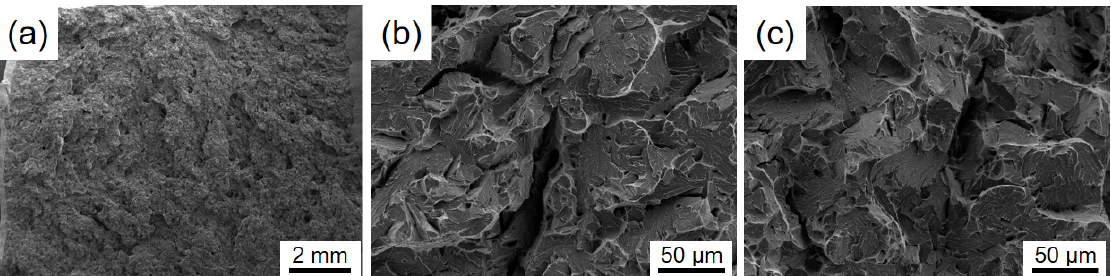
Figure 8. Morphology of fracture surface of Q1050 impact tested specimen. ( a ) overall macro-morphology of fracture surface, ( b ) micro-morphology of fracture surface close to the notch, ( c ) micro-morphology of fracture surface at the center.